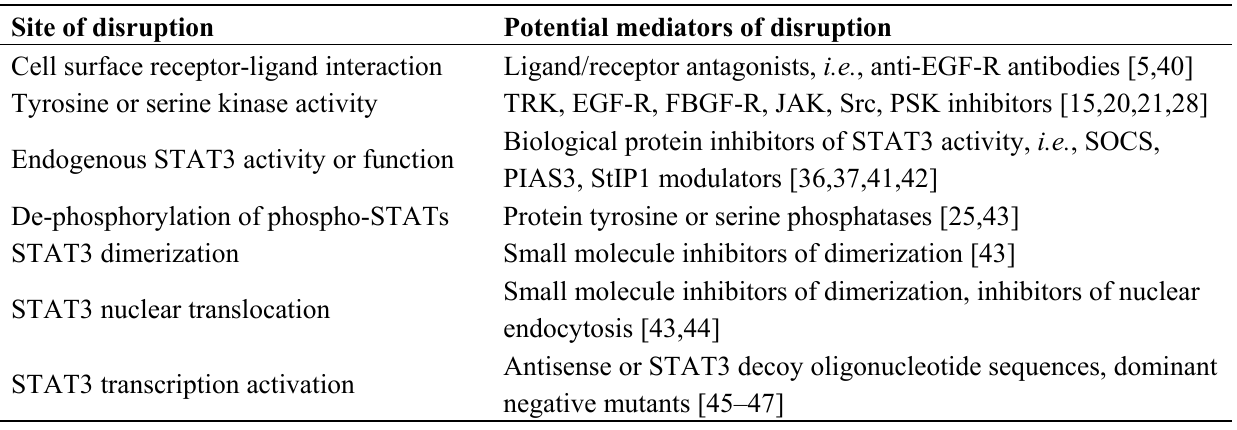
Table 1. Sites of potential STAT3 signal